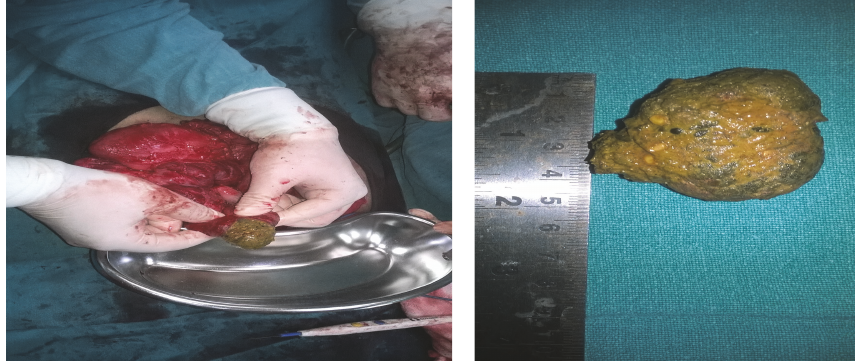
Figure 2: Intraoperative appearance of enterolith impacted in the mid ileum following